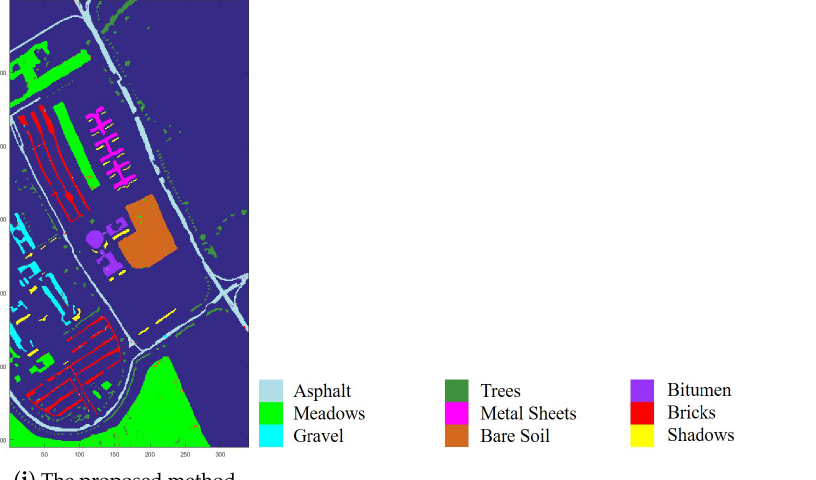
Figure 8. Classification maps of different methods on Pavia University dataset (a total of 1800 labeled samples were used for training).